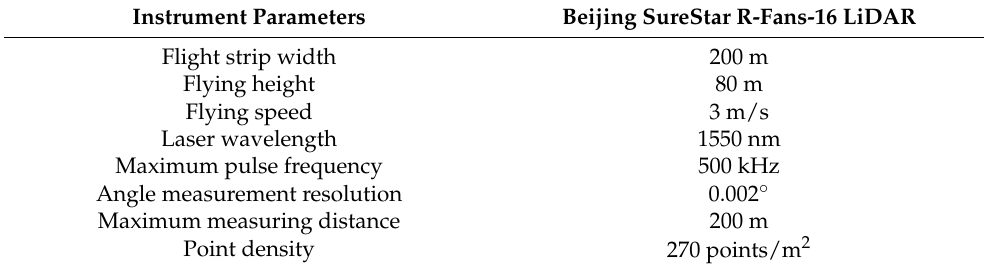
Table 2. Unmanned Aerial Vehicle Laser Scanning (UAVLS) parameters